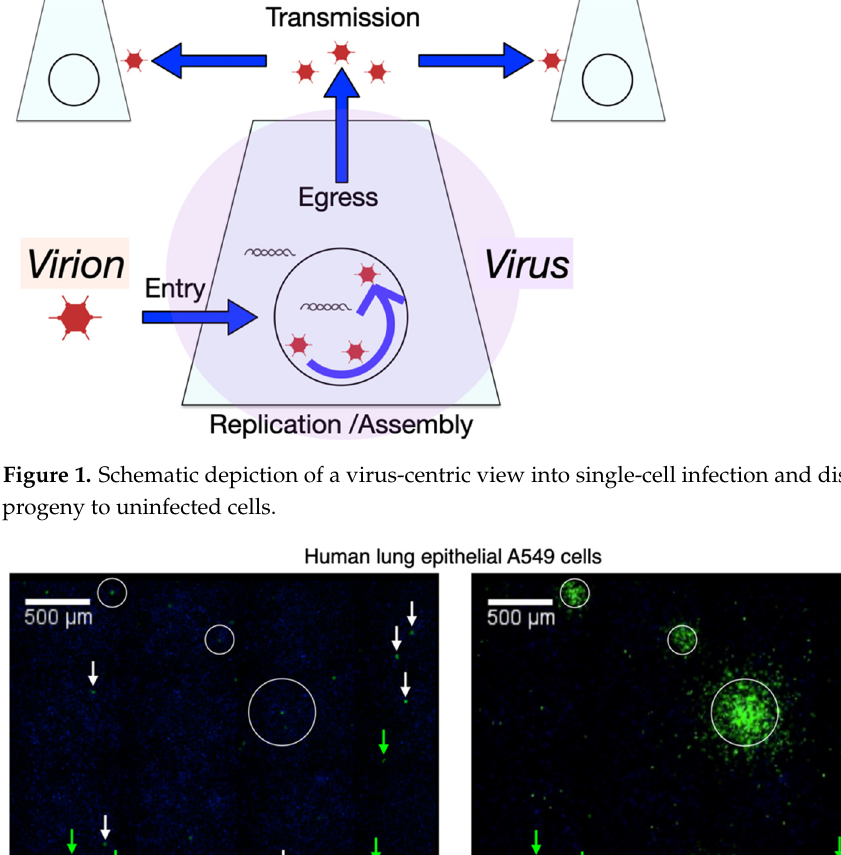
Figure 1. Schematic depiction of a virus-centric view into single-cell infection and dissemination of progeny to uninfected cells.